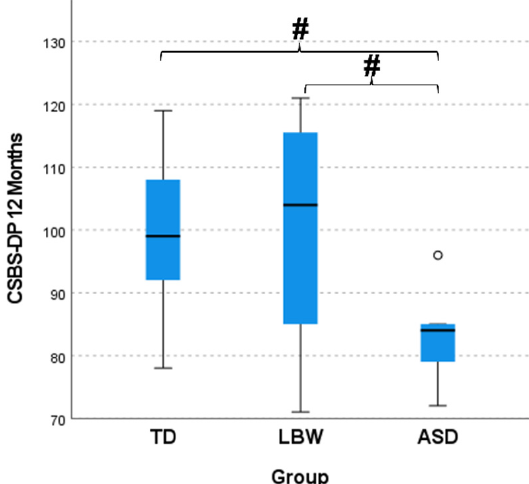
Figure 4. Communication and symbolic behavior scales developmental profile (CSBS-DP) scores at 12 months of age. TD, infants with typical development; LBW, infants born prematurely and with low birth weight; ASD, infants with a sibling diagnosed with ASD. The # sign indicates significant differences between groups, while the ° denote outliers.